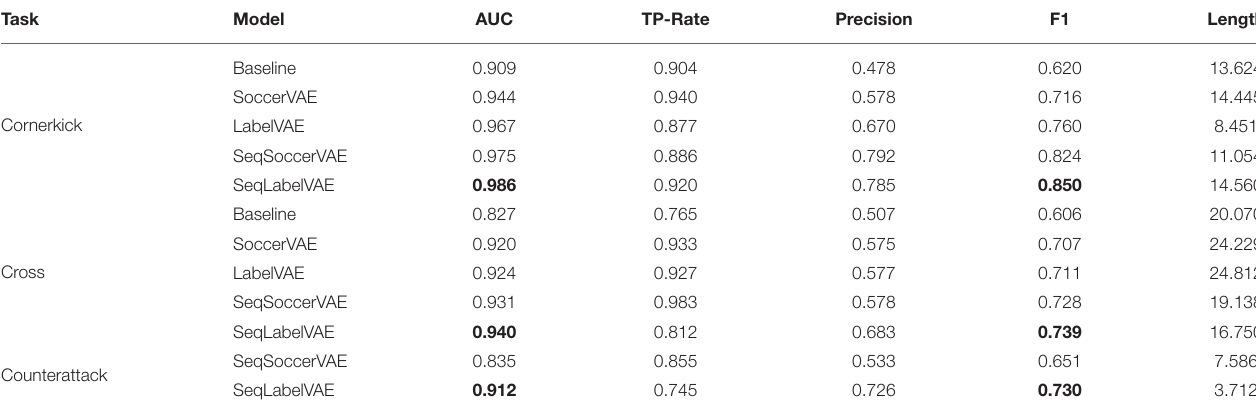
TABLE 1 | Results for the detection of cornerkicks, crosses and counterattacks. Task Model AUC TP-Rate Precision F1 Length